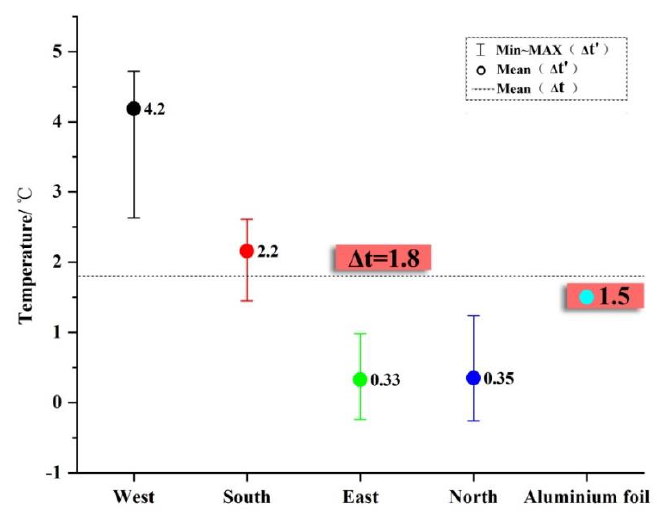
Figure 18. Temperature deviations of all orientations.